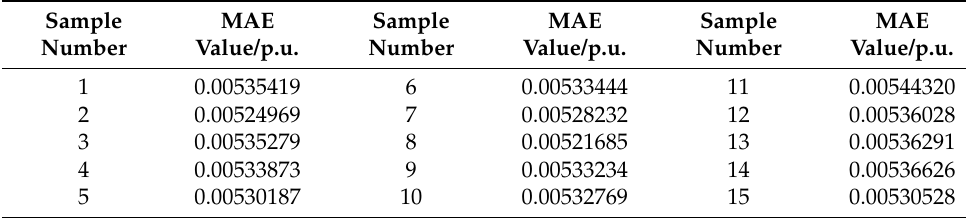
Table 5. Calculation results of evaluation indicator